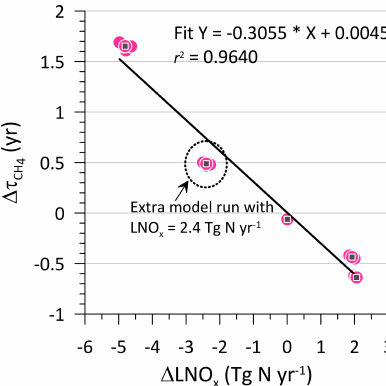
Figure 11. Same as Fig. 8, except for change in the modelled global column integrated CN